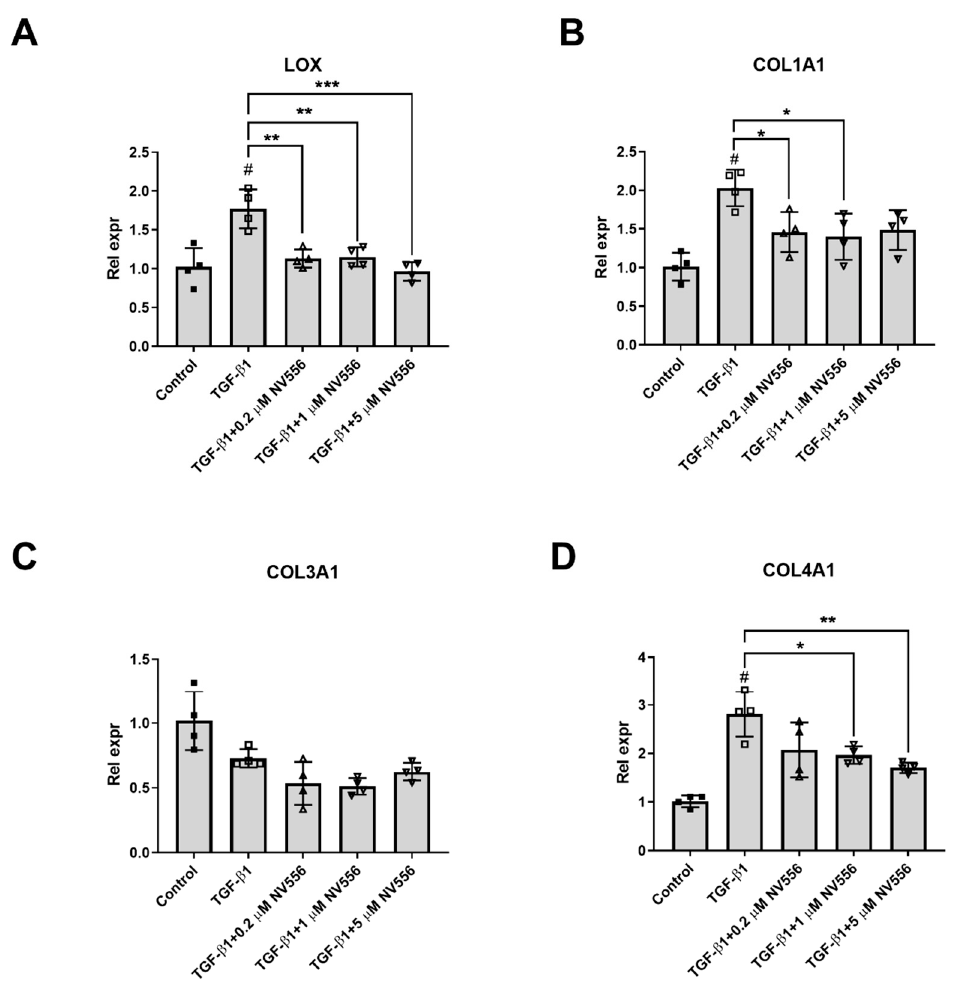
Figure 5. NV556 dose-response effect on gene expression in 3D human liver model reseeded with LX2 cells. Data are represented as mean of relative expression to inactive control ± SD for LOX ( A ), COL1A1 ( B ), COL3A1 ( C ) and COL4A1 ( D ) expression and statistically analyzed by one-way ANOVA, followed by Tukey’s multiple comparison test. * p < 0.05, ** p < 0.01, and *** p < 0.001. # p <0.05 for TGF- β 1 versus nontreated Control cells, n = 4 scaffolds per condition investigated .